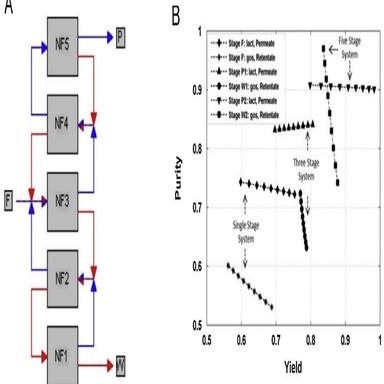
(A) schematic five NF cascade. (B) Purity vs yield in a lactose/GOS system.